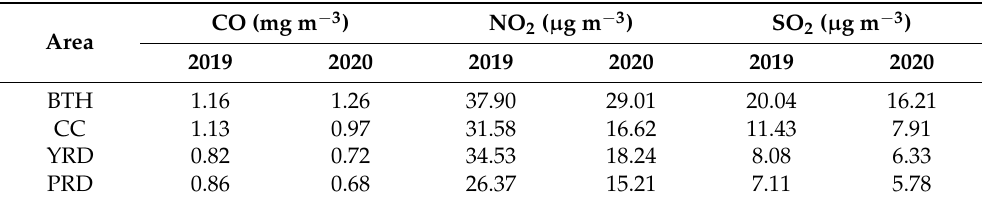
Table 3. Regional monthly average gas pollutants (CO, NO 2 , SO 2 ) mass concentration in FMC_2019 and FMC_2020.